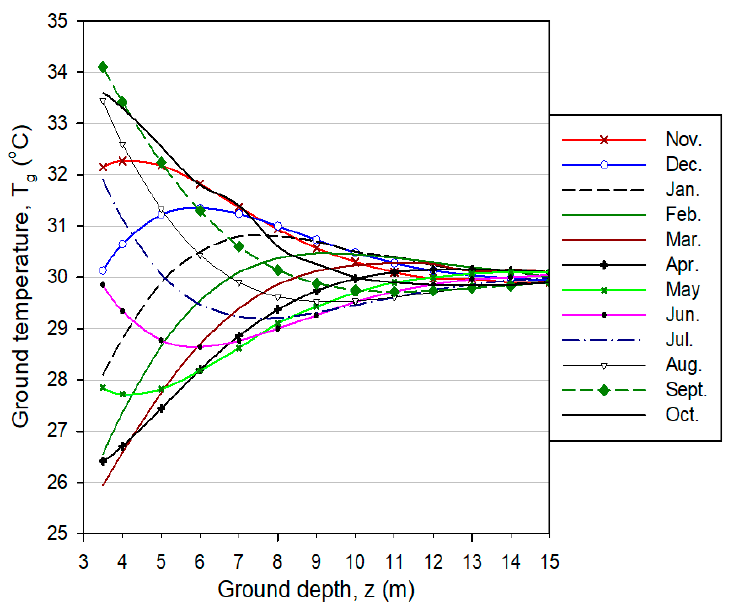
Figure 5. Annual variation in temperatures of ambient air ( T am ) and ground soil ( T g ) at 0.5- and 3.0-meter depths for Riyadh, Saudi Arabia.